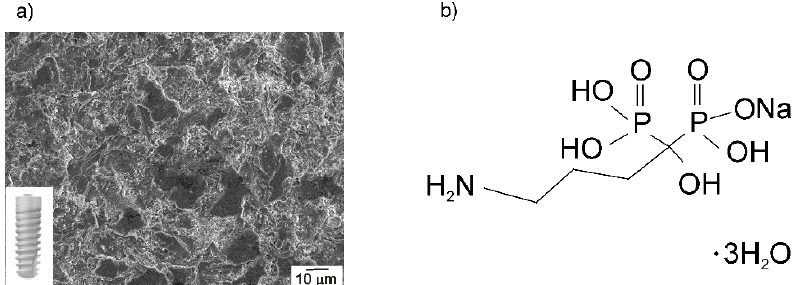
Table 1. Chemical composition (wt %) of titanium c.p. grade 2 [41].